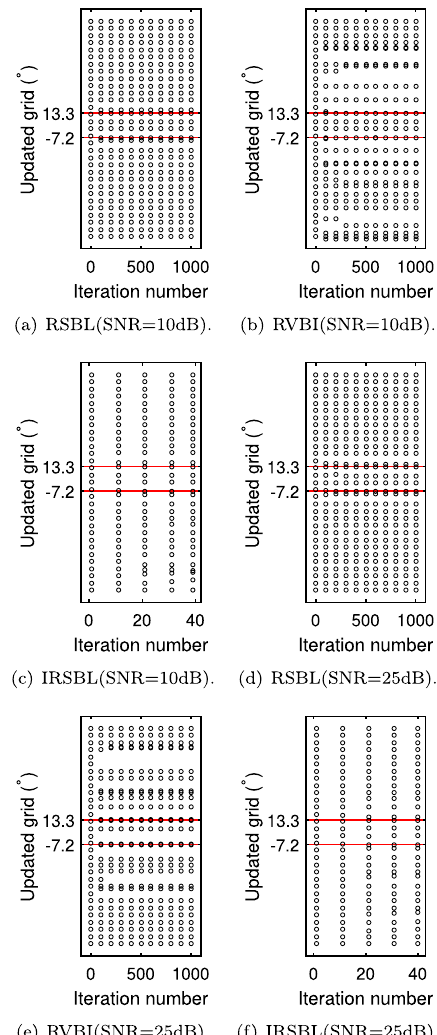
Fig. 5 Evolution of the spatial angle